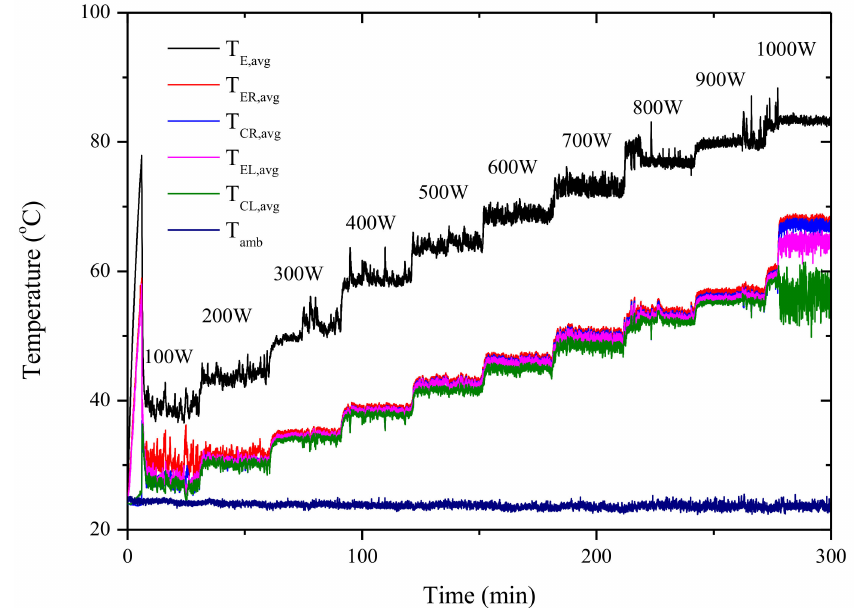
Figure 8. Temperature variation for the proposed PHP vs. elapsed time.